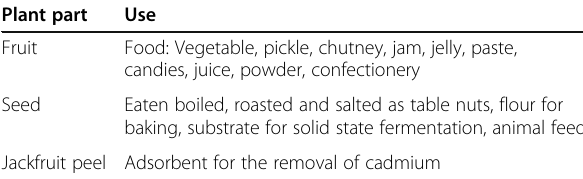
Table 3 Phenolic, flavonoid content, and antioxidant activity of Jackfruit in undigested and digested extracts [59, 60]